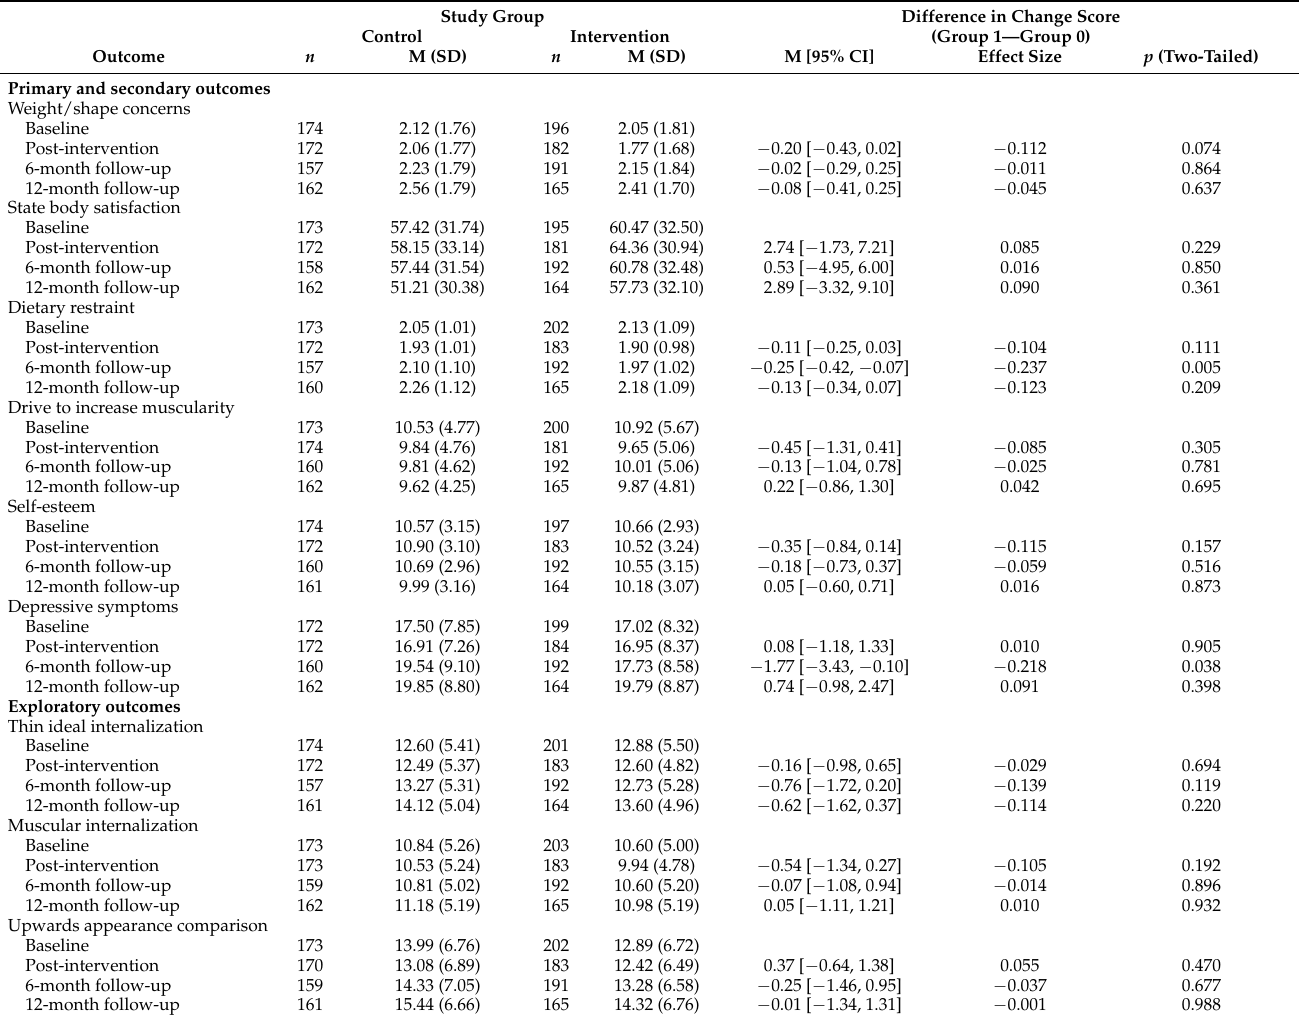
Table 4. Mean changes in study variables at post-intervention and 6- and 12-month follow-up for girls only. Study Group Difference in Change Score Control Intervention Effect Size p (Two-Tailed)